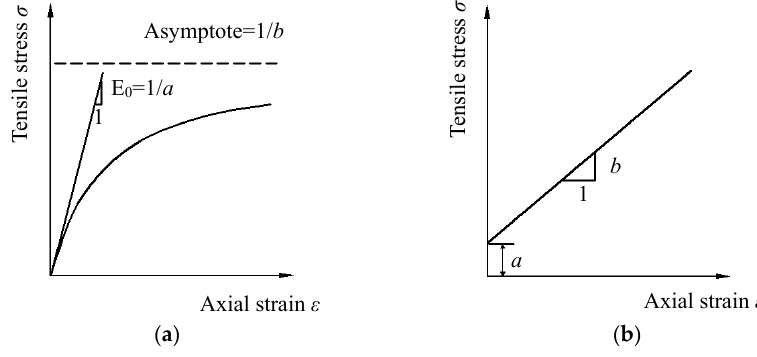
Figure 20. Physical meaning of parameters a and b: ( a ) hyperbolic stress-strain curve; ( b ) transformed hyperbolic stress-strain.